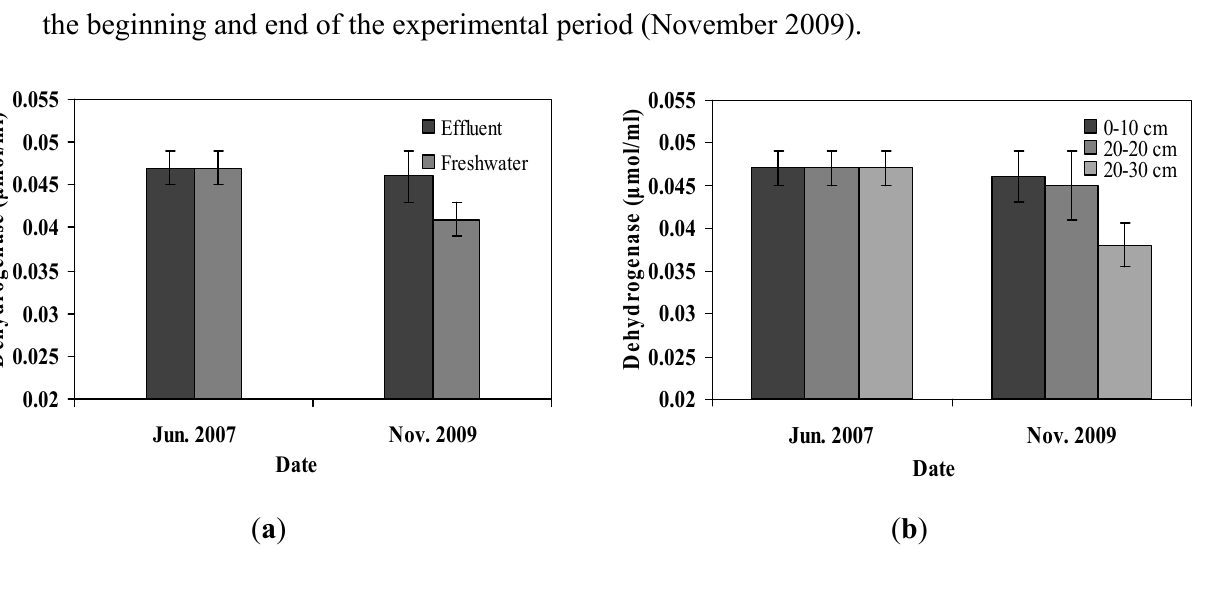
Figure 4. Dehydrogenase activity as a function of ( a ) water quality; and ( b ) soil depth, at the beginning and end of the experimental period (November